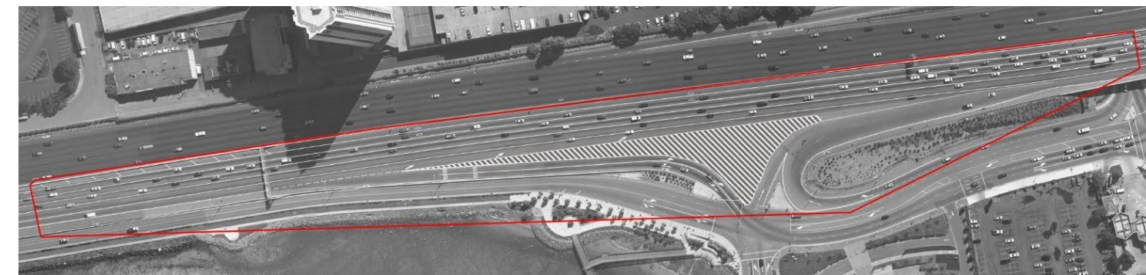
Figure 3. I-80 highway segment lane layout diagram.